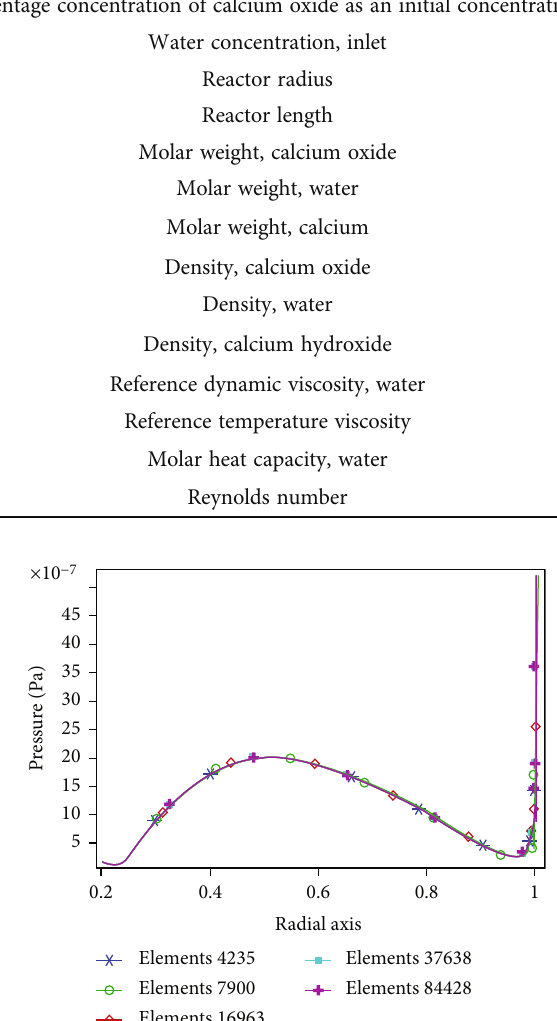
Figure 3: The computational results for the pressure downstream of the channel at the di ff erent con fi gurations of